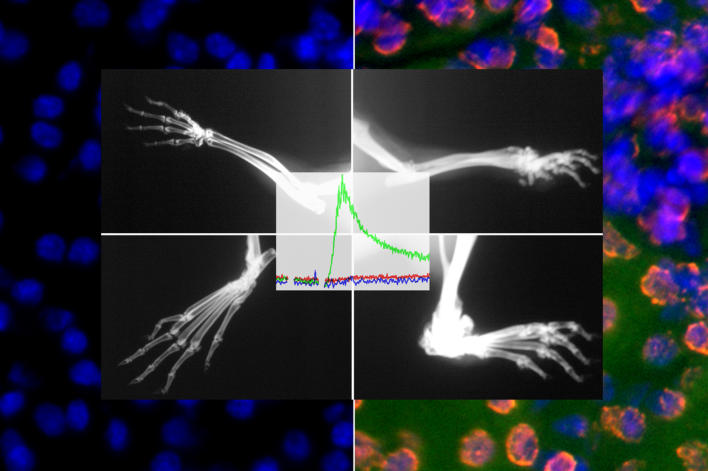
Self-reactivity of T cells can be down-regulated by cell-intrinsic adaptation (as indicated by reduced calcium ? uxes of adapted T cells shown in the center inset). Left and right panels show samples from mice with and without autoreactive T cells, respectively. (Image: Nevil Singh et al.)